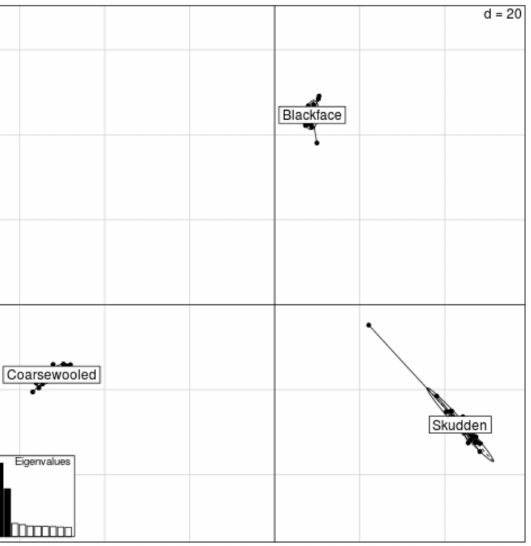
Figure 2. Principal component plots for the Lithuanian sheep, based on SNP data. As shown by the scree diagram, the two first components explaining 15% and 10% of the variation are sufficient for describing the main structure among the sheep, d-dimensional